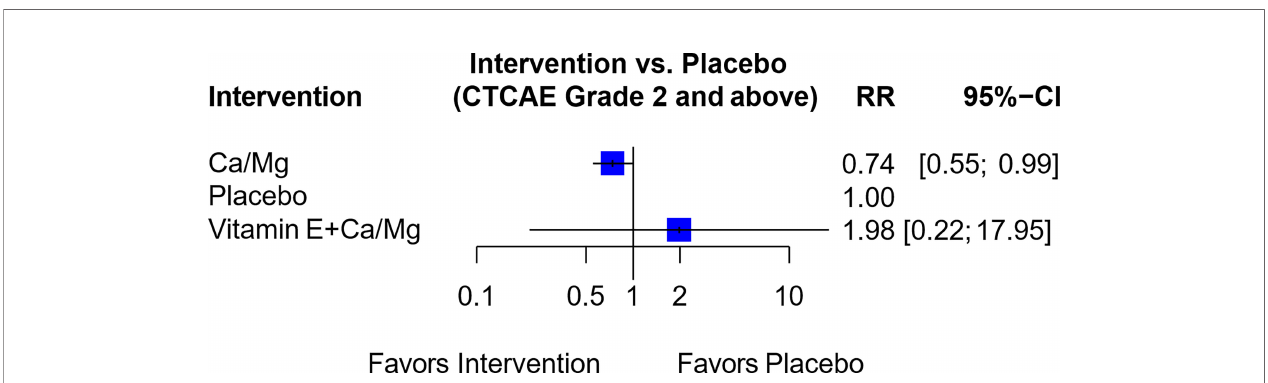
FIGURE 8 | Forest plot for network analysis comparing Vitamin E + Ca/Mg, Ca/Mg and placebo on the risk of OIPN of CTCAE grade ≥ 2. Risk ratio comparing combination therapy “ Vitamin E+ Ca/Mg ” against placebo was derived indirectly from network meta-analysis, while the risk ratio comparing Ca/Mg against placebo was derived directly from 6 trials that conducted the exact comparison.